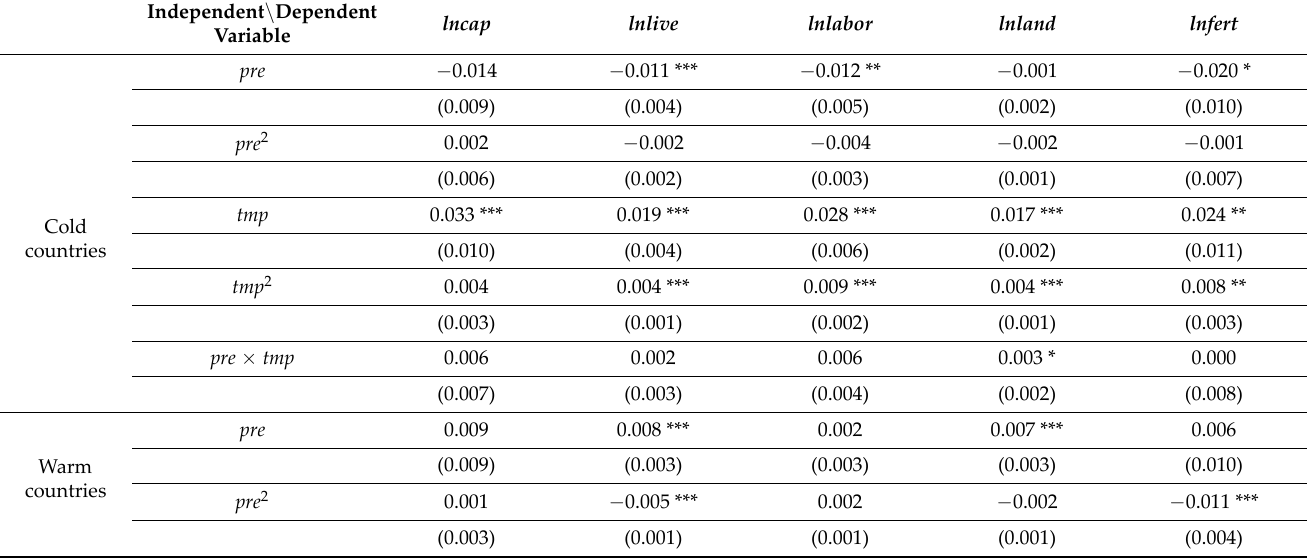
Table A3. Climate change impacts on agricultural inputs across countries with different temperature